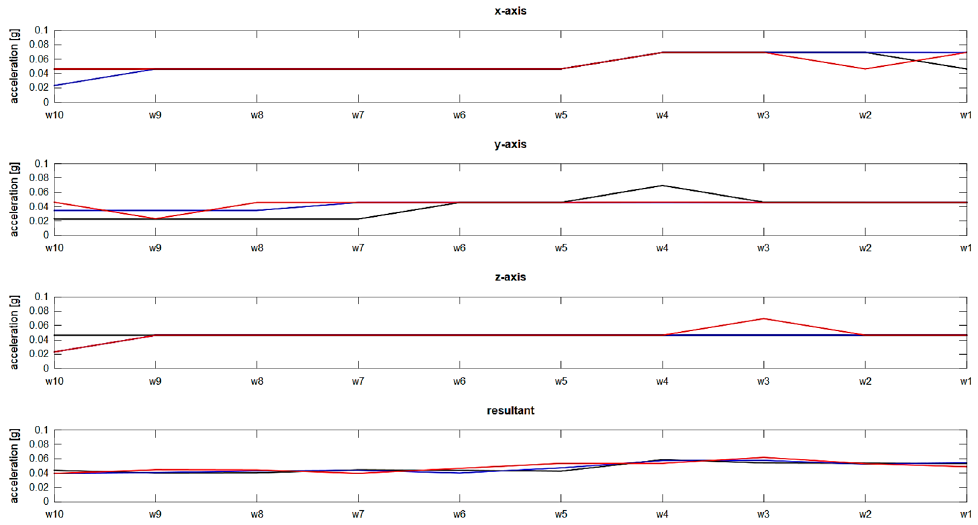
Figure 3. Median values of the ROM for the three axes and the resultant acceleration of the bow arm. Every graph contains the values for C1 (black), C2 (blue) and C3 (red).